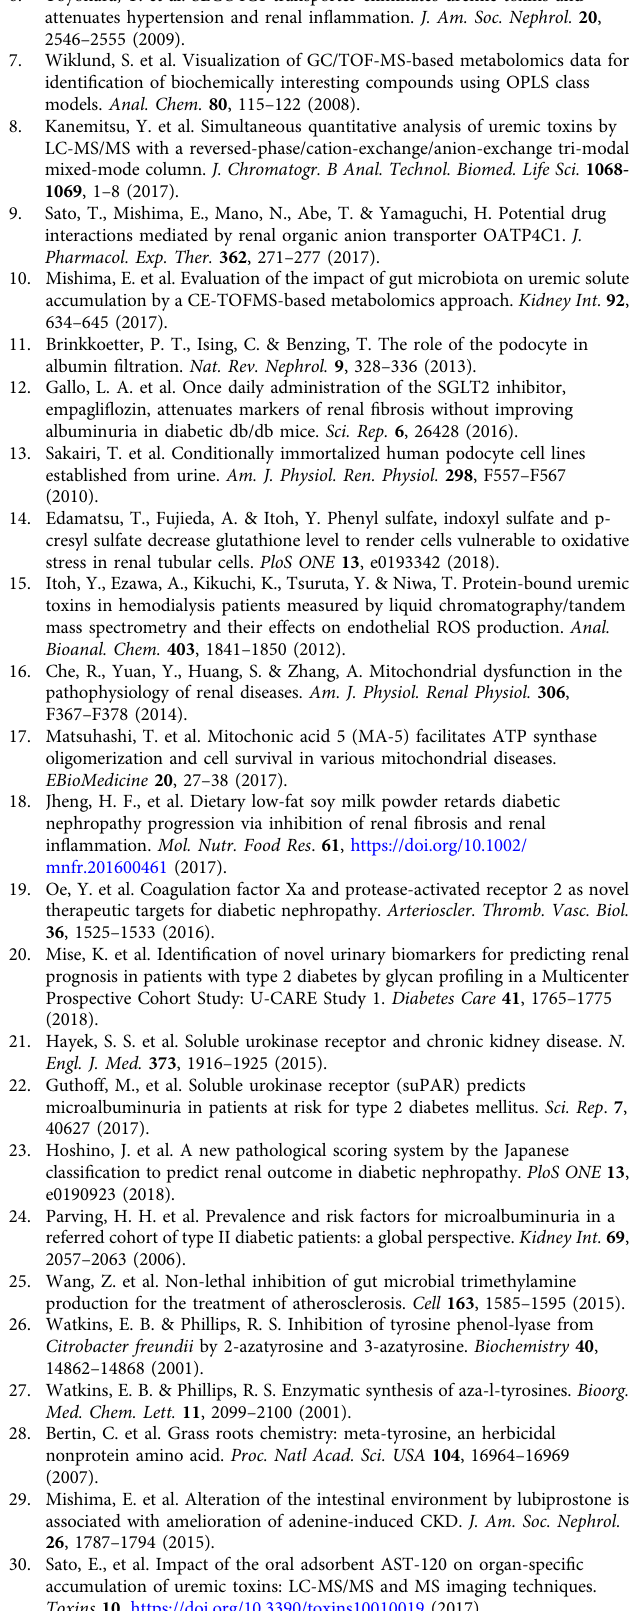
Table 10. The sequences of the primers and probes are certi fi cated by the company, but not open based on the company policy. Western blot . Western blotting of ileum and colon were performed as previously described 61 . The primary antibodies against claudin 1 (1:1000 dilution, ab15098), occludin (1:1000 dilution, ab31721), and ZO-1 (1:1000 dilution, abG041) were purchased from Abcam. Statistical analysis . The data are expressed as means± SEM or SD. * p < 0.05, ** p <0.01, and *** p < 0.001 were considered statistically signi fi cant. JMP Pro software version 12 (SAS Institute., Cary, NC) was used for the statistical